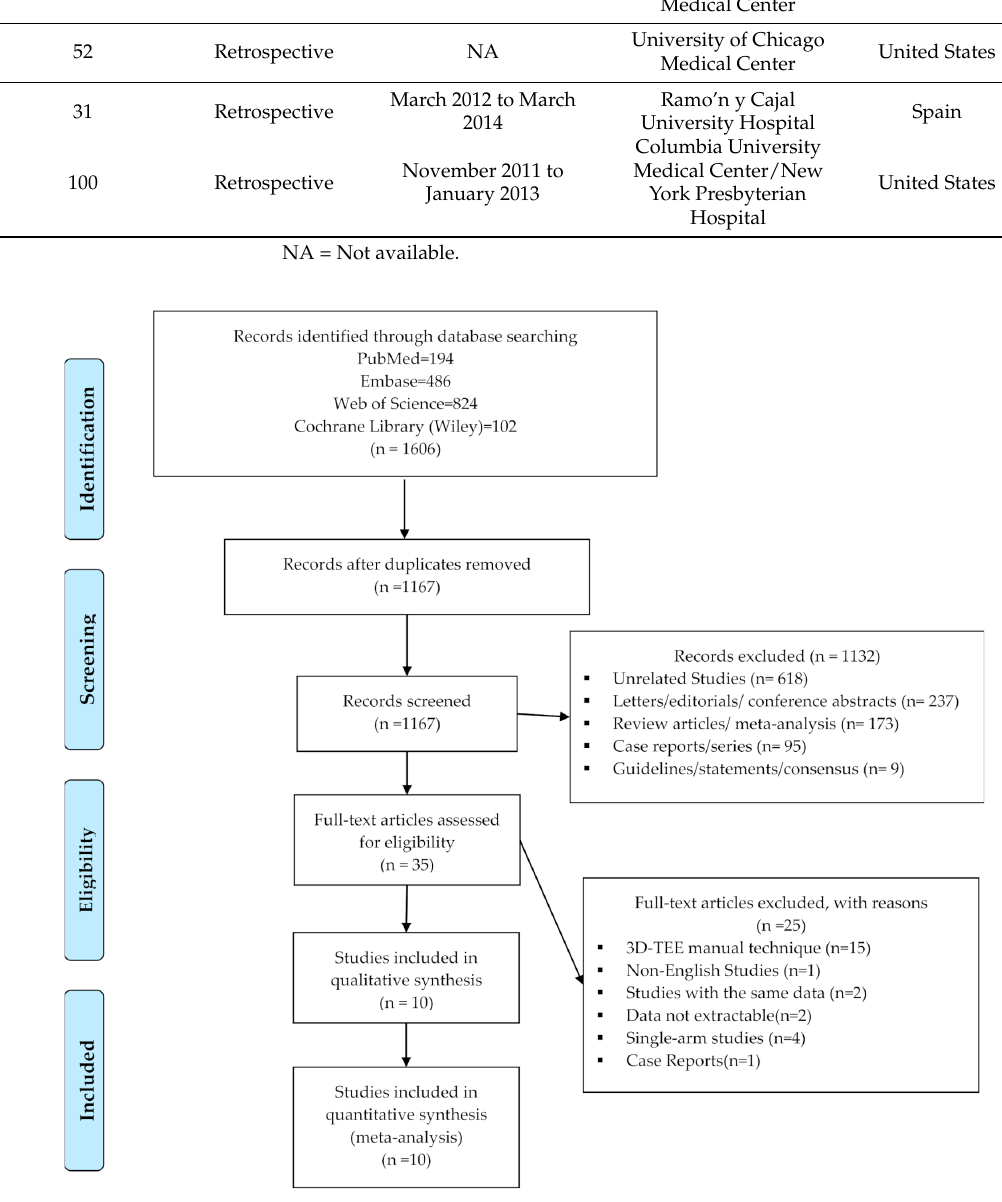
Figure 1. PRISMA flow diagram of the study selection process. 3D-TEE = Three-dimensional transesophageal echocardiography, n = Number of literatures, PRISMA = Preferred Reporting Items for Systematic Reviews and